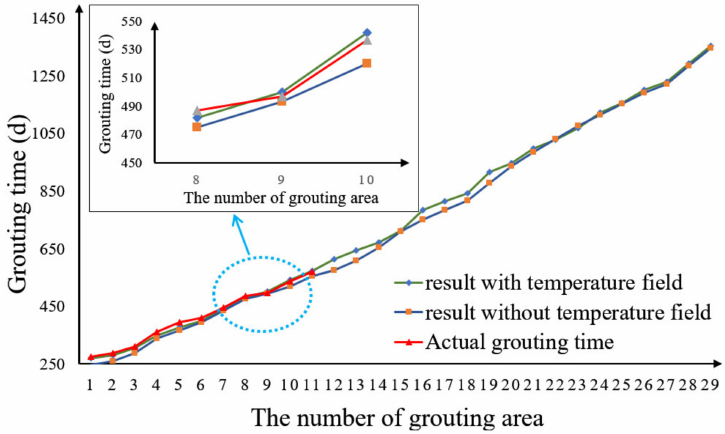
Figure 9. The comparison of the joint grouting time with and without the temperature